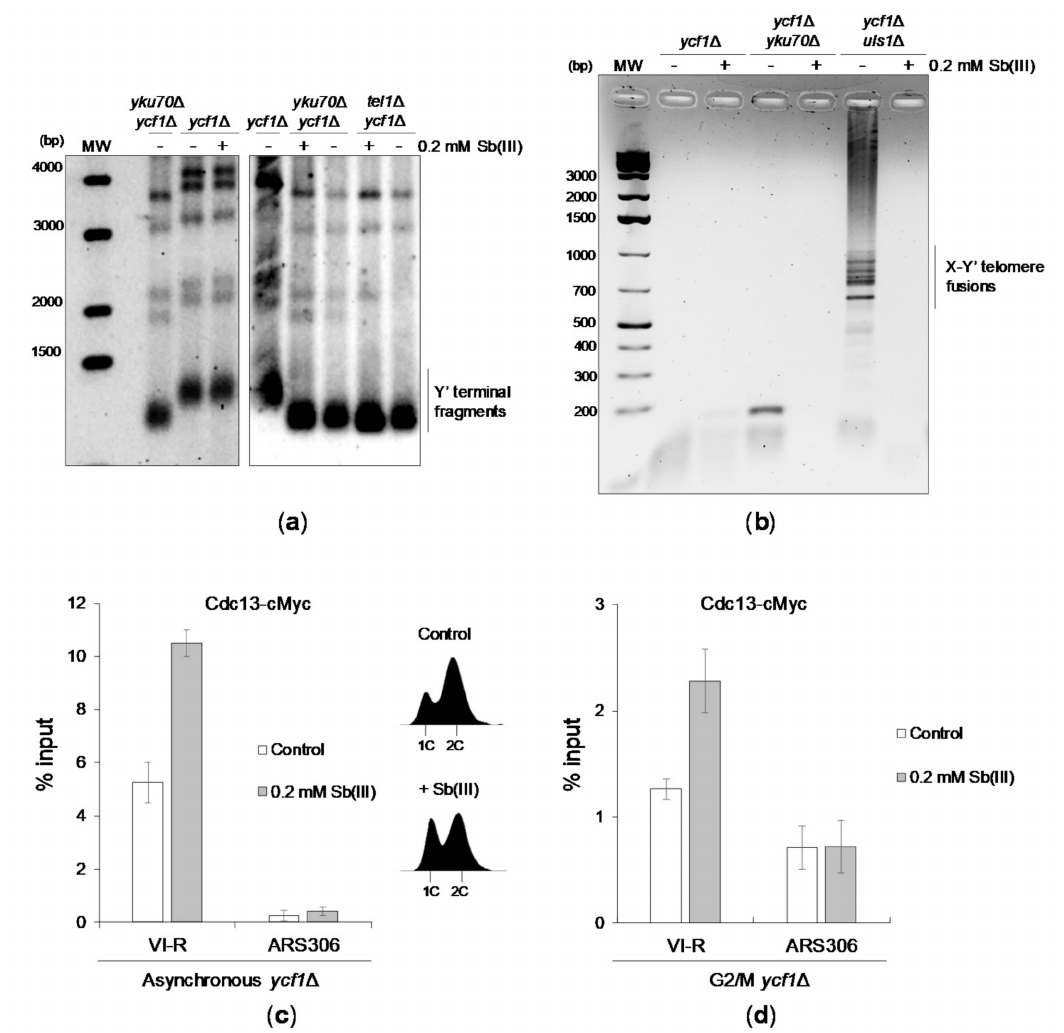
Figure 8. The effect of Sb(III) on telomere homeostasis. ( a ) Sb(III) does not alter telomere length in yeast cells. Cells of indicated strains were cultivated for six days in the presence or absence of Sb(III). Afterwards, genomic DNA was isolated, digested with Xho I and analyzed by Southern blot using a probe detecting Y’ telomere repeats. ( b ) Sb(III) inhibits telomere fusions in cells lacking Uls1. Indicated strains were cultivated in the presence or absence of 0.2 mM Sb(III) for 6 days followed by genomic DNA preparation and PCR analysis of fusions between X and Y’-only telomeres using a pair of primers specific for X and Y’ subtelomeric regions. ( c , d ) Cdc13 association with telomeric DNA is increased in the presence of Sb(III). The telomere VI-R DNA binding of cMyc-tagged Cdc13 in ycf1 ∆ cells treated or not treated with 0.2 mM Sb(III) for 2 h was analyzed by ChIP performed with anti-Myc antibodies followed by qPCR. ARS306 locus was used as a control for the Cdc13-free internal chromosome region. The % input value represents the enrichment of Cdc13-cMyc protein at the specific locus and is normalized to the ACT1 reference gene. Error bars are standard deviations from two independent experiments. DNA content analysis of asynchronous cultures used for ChIP-qPCR is embedded in panel